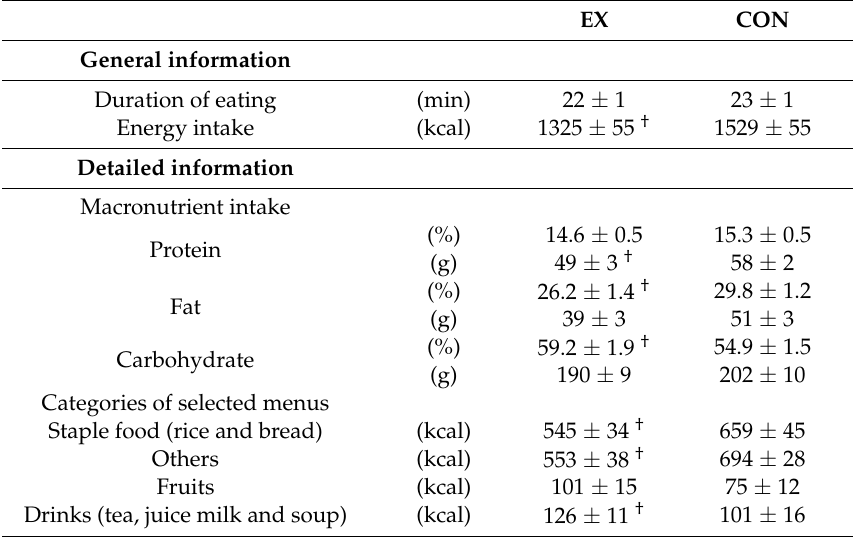
Table 3. Energy intake, macronutrient intake ratio and categories of selected menus.